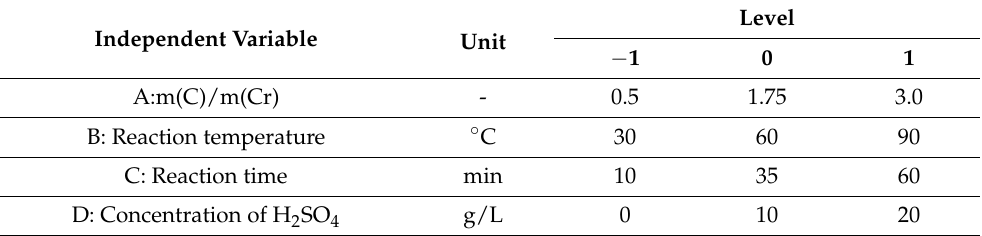
Table 1. Independent variables and factor levels.